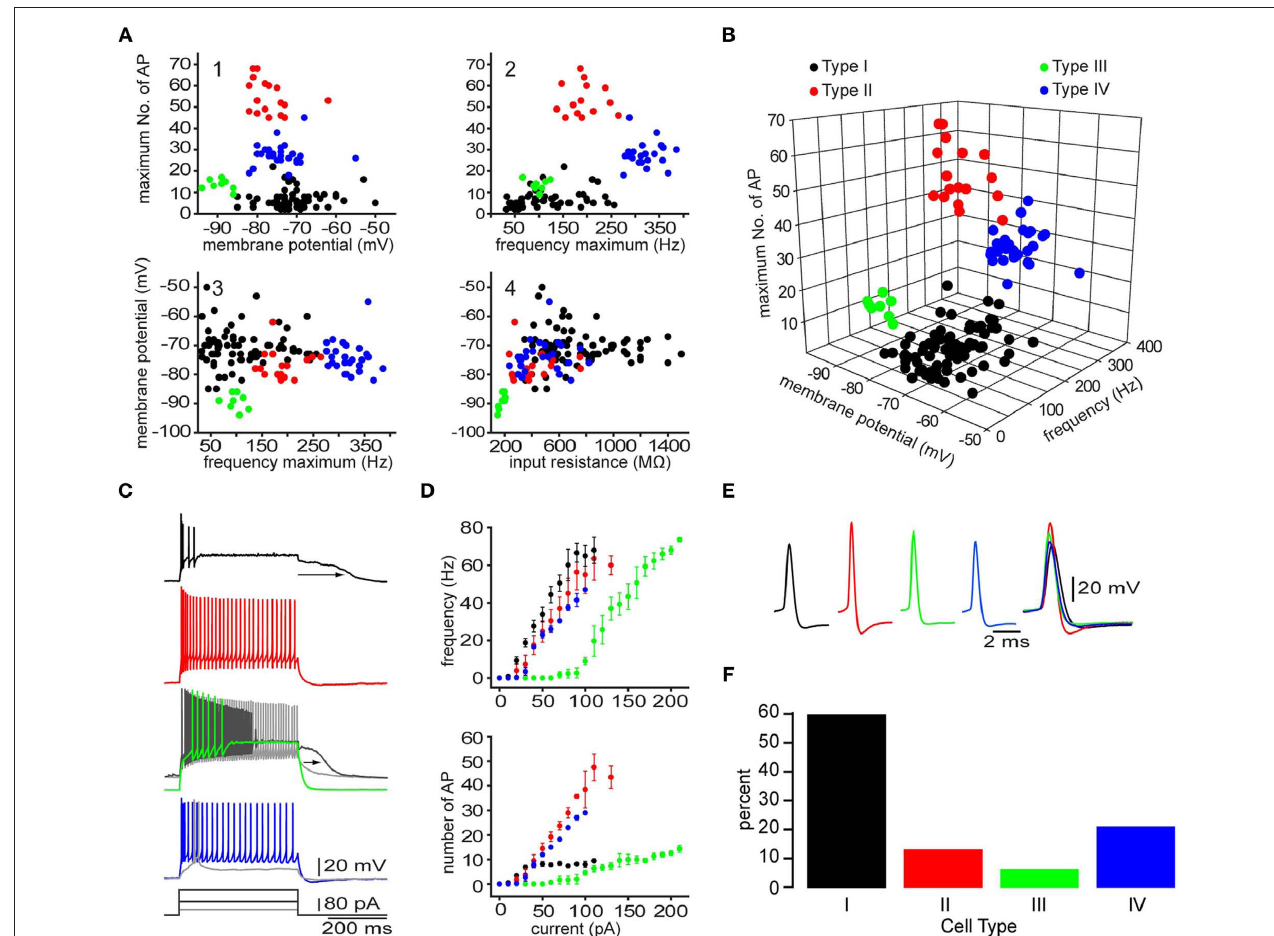
striatal TH + types neurons. Note the plateau potential that was evoked in the Type I (arrow) at rest and in a slightly depolarized Type III neuron (arrow), using a stronger depolarizing current injection (180 pA). The Type III fires throughout the depolarizing current (gray line). In addition, the Type IV interneuron exhibits a clear LTS component in response to a small depolarizing current injection (40 pA), at its resting membrane potential. (E) Averaged action potentials from cell Types I-IV clearly show differences in multiple spike waveform parameters. (F) Histogram showing the distribution of the four EGFP–TH + cell